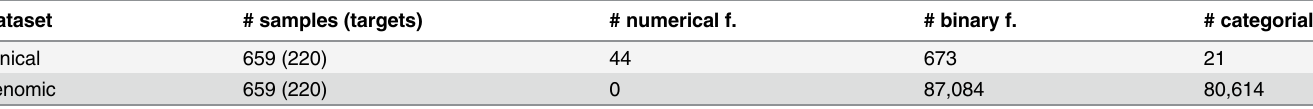
Table 2. Overview of the two biomedical datasets used to evaluate CloudForest. The columns indicate (from left to right): the number of samples with the number of positives samples (targets) in parentheses, the number of numerical features, the number of binary features and the number of categorical features.